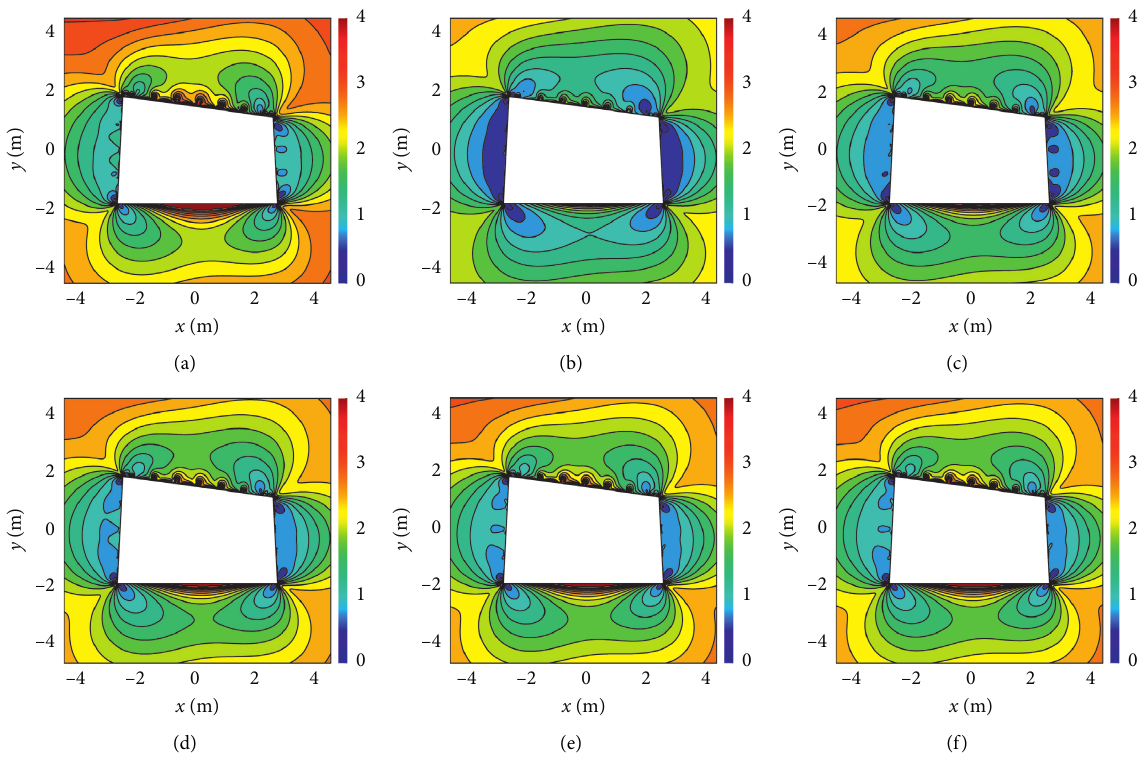
Figure 11: Contour map of SRSI of IRMR in the full-length anchoring zone at different distances from the working face. (a) l � 30m.